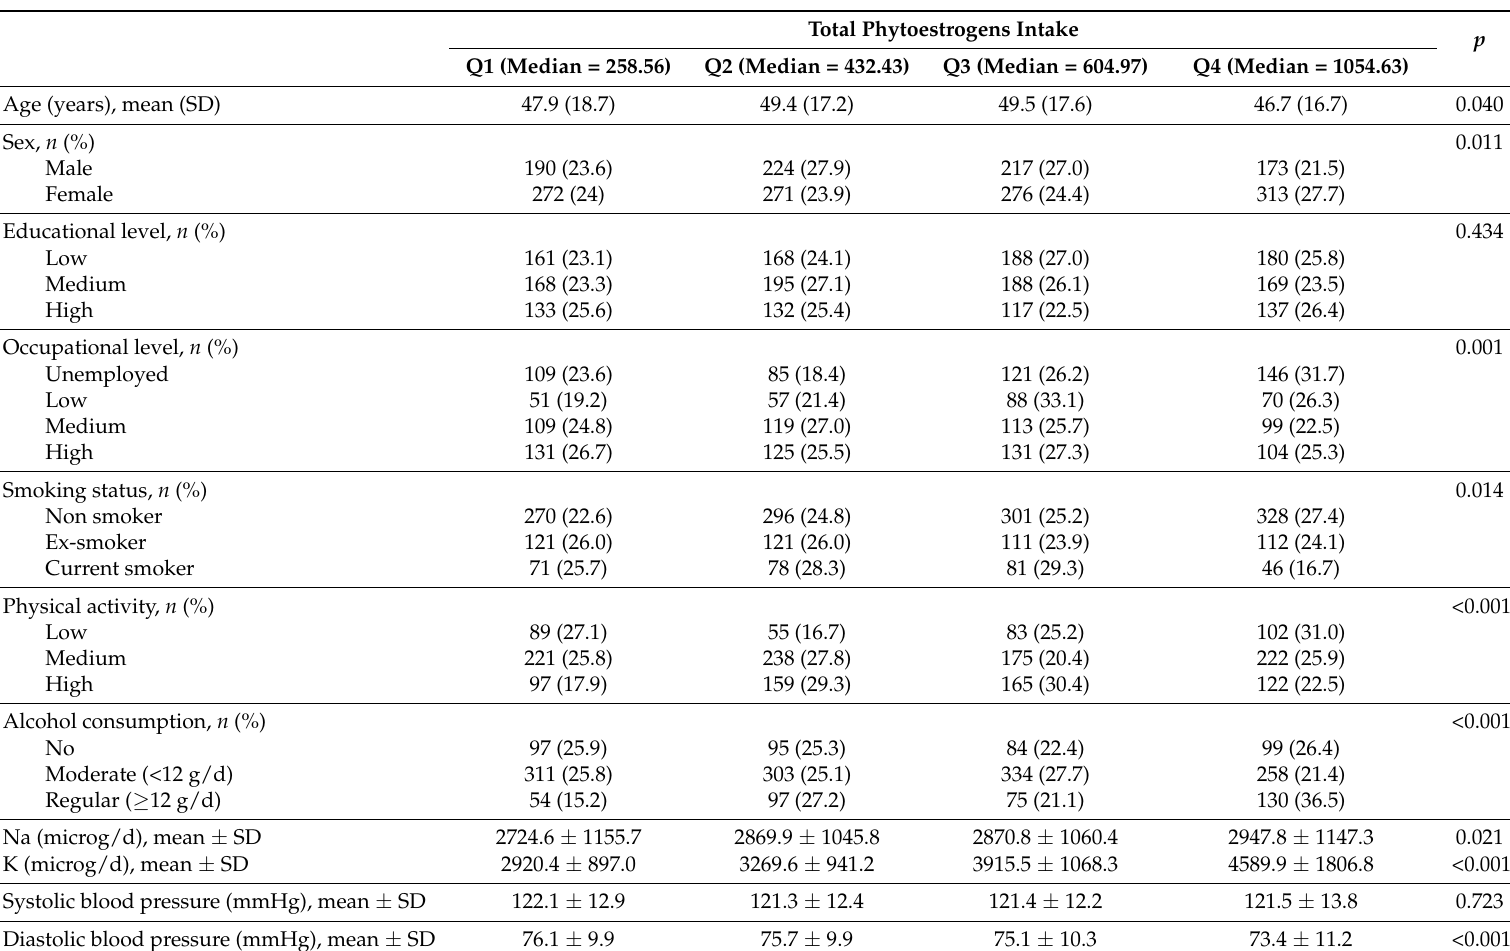
Table 1. Baseline characteristics by quartiles of dietary phytoestrogens intake in the Mediterranean healthy eating, aging, and lifestyle (MEAL) study sample ( n =